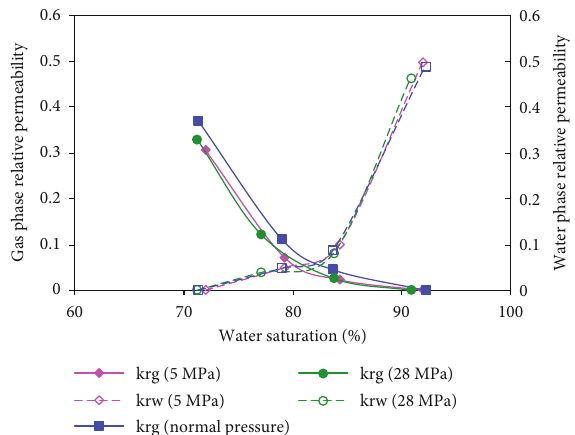
Figure 4: In fl uence of pressure on gas – water relative permeability curves.